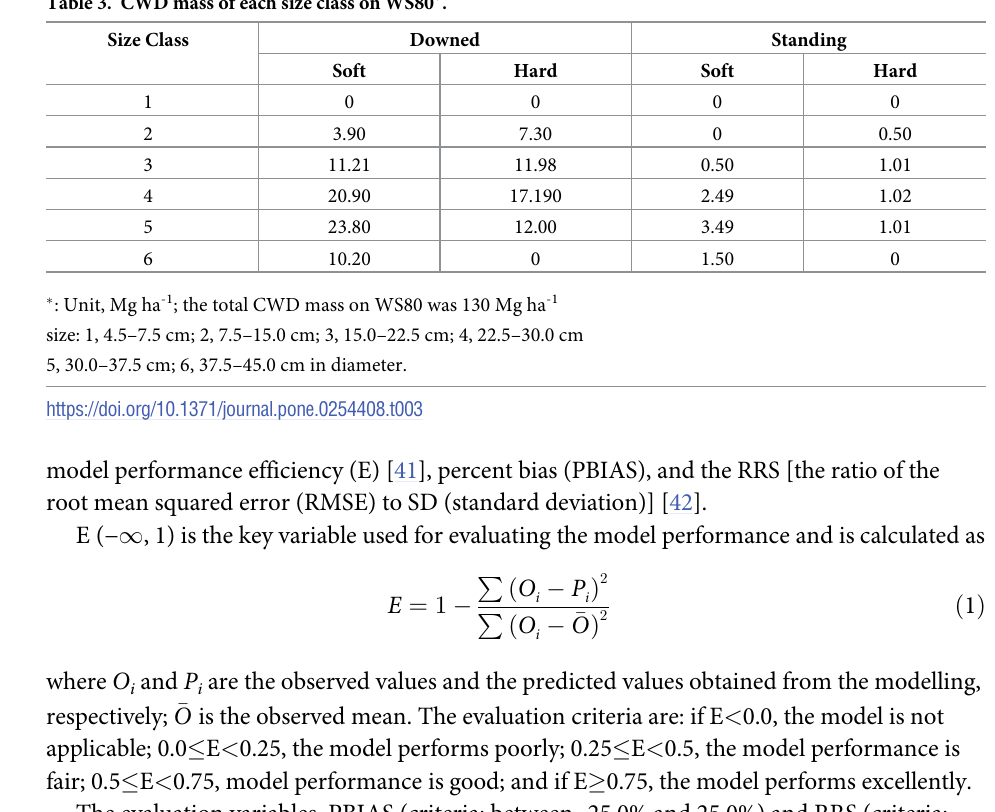
and where SD is the observed standard deviation; RMSE is the root mean squared error between observed and simulated values, calculated as where n is the number of samples or the pairs of the observed and simulated values. The time to achieve 50% mass loss of CWD from the original mass (half-life, T metric for comparing decomposition responses; it was calculated as where k is the decomposition constant, y -1 , based on the single exponential model that is widely used to assess CWD decomposition as follows,